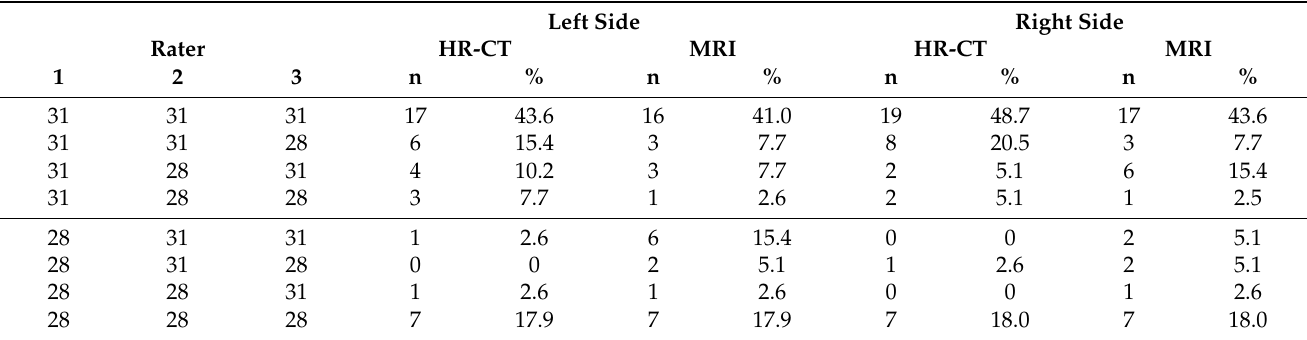
Table 2. Number of electrode arrays selected as the most appropriate by the 3 raters (Rater columns: 31 = 31.5 mm electrode array selected, 28= FLEX 28 electrode array selected). Left